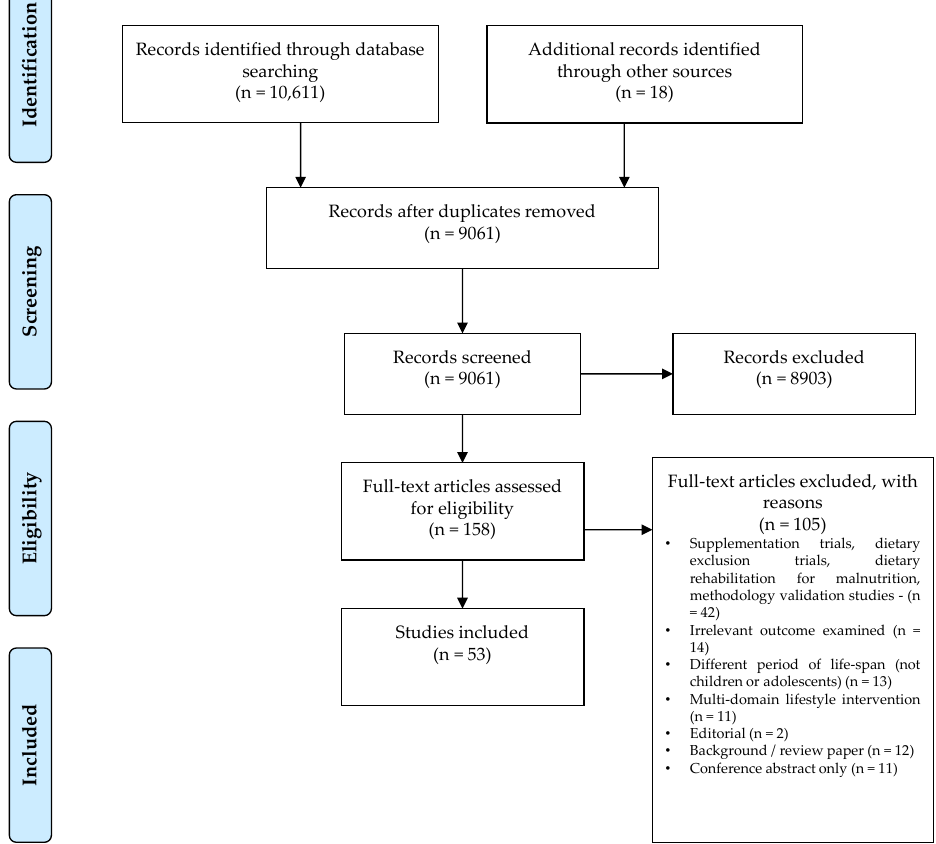
Figure 1. Study selection flow chart including reasons for exclusion of studies during full text screening.